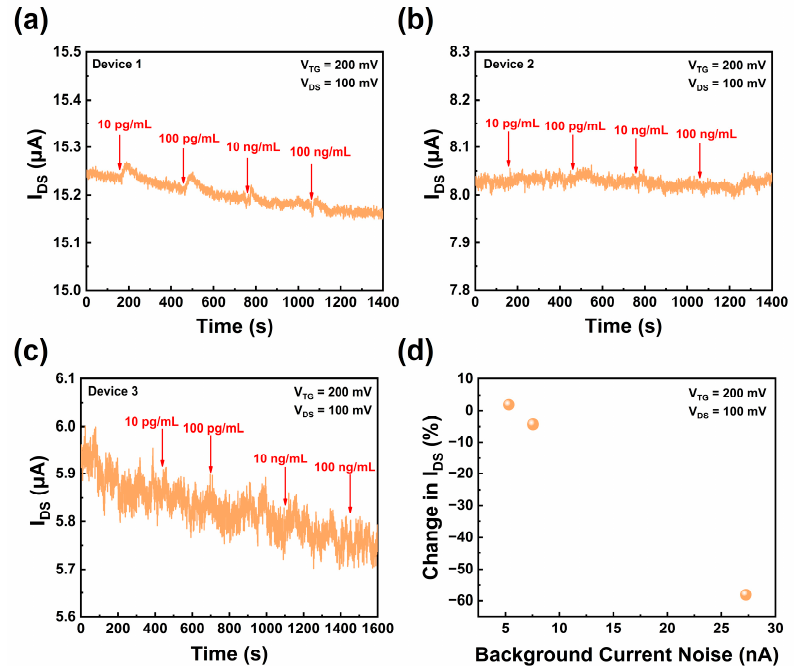
Figure 6. Detection of SARS-CoV-2 antigen protein and the relationship between the change in graphene biosensor current induced by PBASE modification and the background current noise of graphene biosensor. ( a – c ): The real-time current responses of Device 1, Device 2, and Device 3 upon SARS-CoV-2 antigen proteins, respectively. During the measurements, the V TG was kept at 200 mV and the V DS was kept at 100 mV. ( d ) The relationship between the calculated change in I DS of the graphene biosensor before and after the non-covalent functionalization of the graphene surface via PBASE and the estimated background current noise of the biosensor during the real-time detection of antigen proteins.